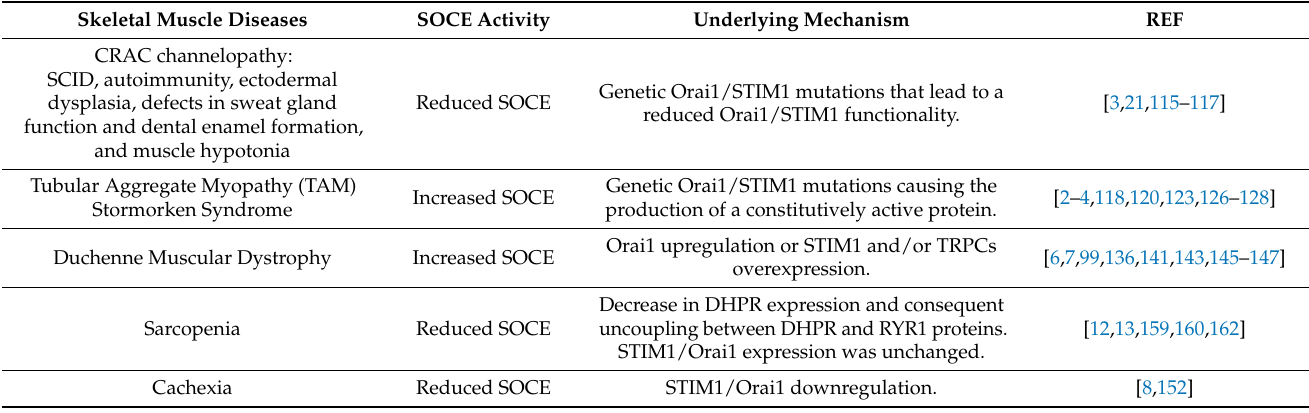
Table 1. Altered SOCE in skeletal muscle